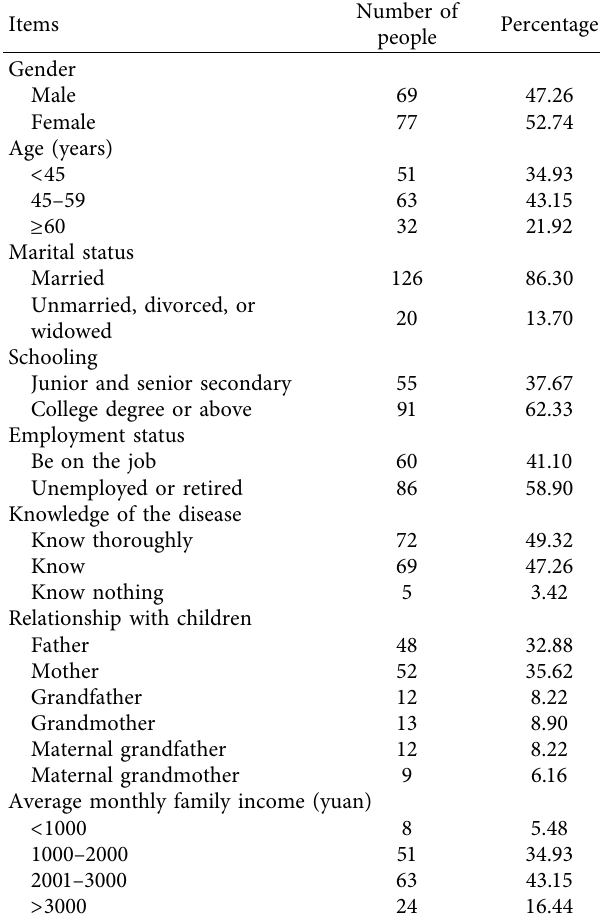
Table 1: General information of the guardian.